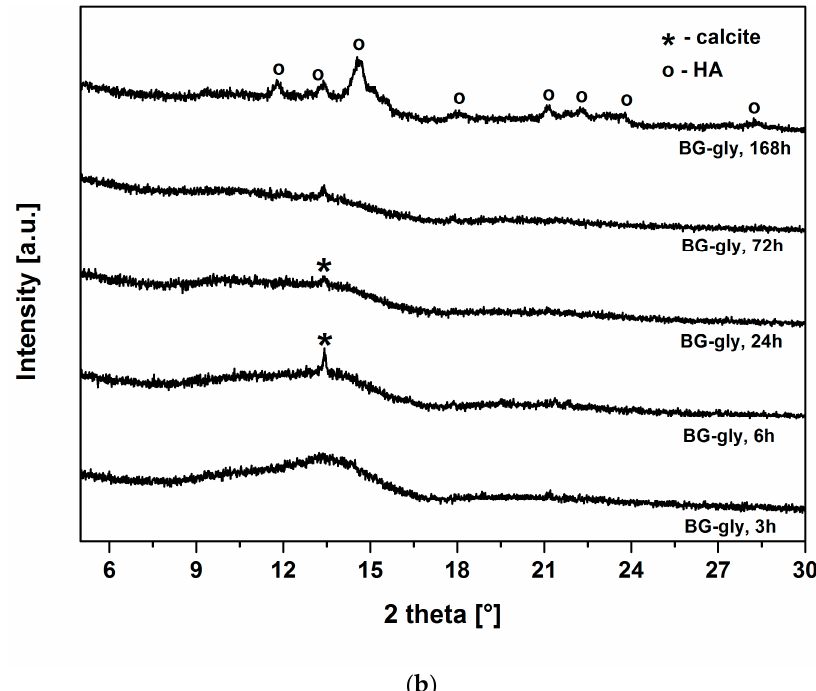
Figure 3. X-ray diffraction (XRD) patterns of ( a ) BG; ( b ) BG-gly paste after immersion in SBF for different periods of time. Materials 2017 , 11, 324